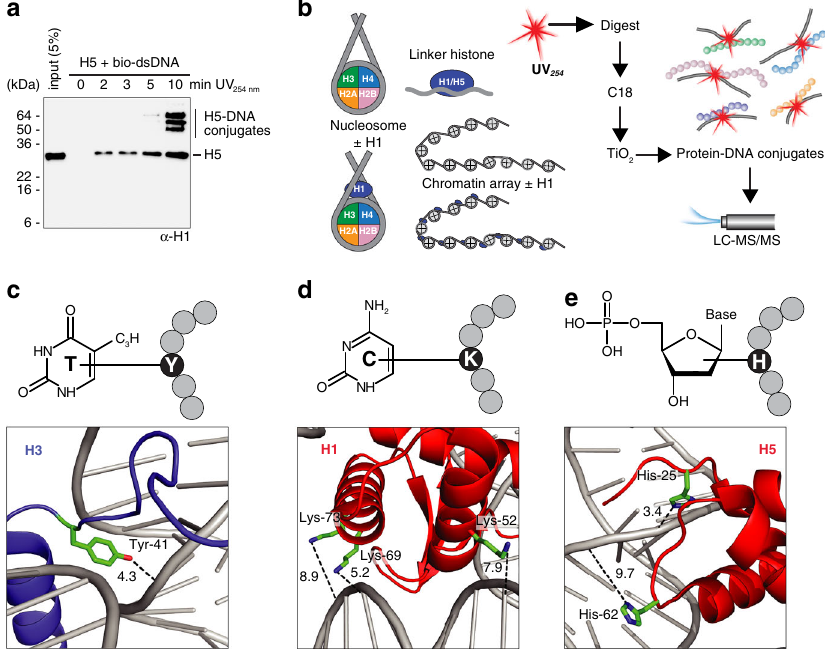
Fig. 1 UV-induced protein-DNA cross-links in histones and nucleosomal samples. a Pull-down of UV (254 nm)-irradiated histone H5 and biotinylated DNA (187 bp). Samples were cross-linked for the indicated times and subjected to salt washes to remove unbound H5. Immobilized H5 was analyzed by western blotting with anti-H1. b Work fl ow for MS analysis of UV-induced cross-links in histone-DNA complexes, nucleosomes and chromatin arrays. c – e Protein-DNA cross-linking types identi fi ed in (linker) histones. c Thymidine-Tyrosine 41 cross-link of histone H3 highlighted in pdb entry 1KX5. d Cytosine-Lysine cross-links of histone H1 in pdb 5NL0. e Deoxyribose-Histidine cross-links of linker histone H5 in pdb 4QLC. Distances (in Ångstrom) were measured between residue side chains and nearest base or deoxyribose in the